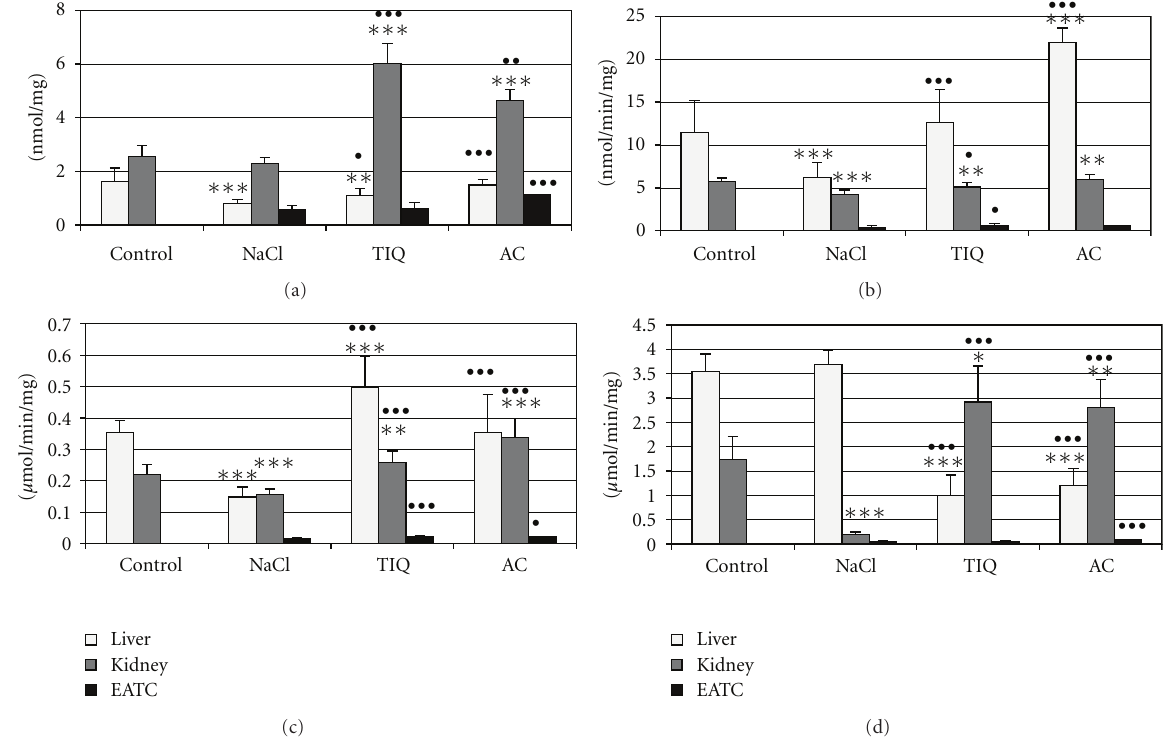
Figure 2: Sulfane sulfur level (a), cystathionase (b), rhodanese (c), and 3-mercaptopyruvate transferase activity (d) in healthy and Ehrlich ascites tumor- (EAT-) bearing mice livers, kidney, and EAT cells. 0.9% NaCl (control groups), 1,2,3,4-tetrahydroisoquinoline (TIQ) at 50mg · kg − 1 of body weight, and acivicin (AC) at 18 mg · kg − 1 were i.p. injected for 5 days. ∗ - P < 0 . 05 versus control, ∗∗ - P < 0 . 01 versus control, ∗∗∗ - P < 0 . 001 versus control, • - P < 0 . 05 versus NaCl, •• - P < 0 . 01 versus NaCl, ••• - P < 0 . 001 versus NaCl.